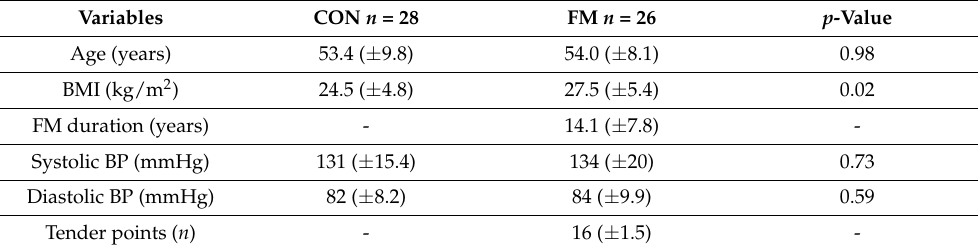
Table 1. Baseline characteristics of healthy controls (CON) and fibromyalgia patients (FM). The data are presented as mean and standard deviation ( ± SD). BMI: body mass index; FM = fibromyalgia; BP: blood pressure.